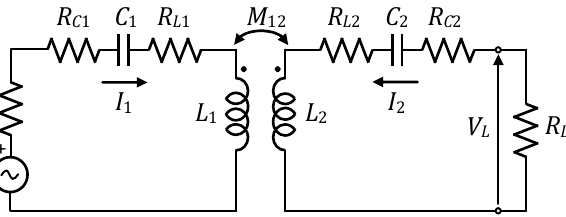
Figure 2. The equivalent circuit model of the magnetically coupled resonant wireless power trans- mission asymmetric system with the series-series compensation structure.